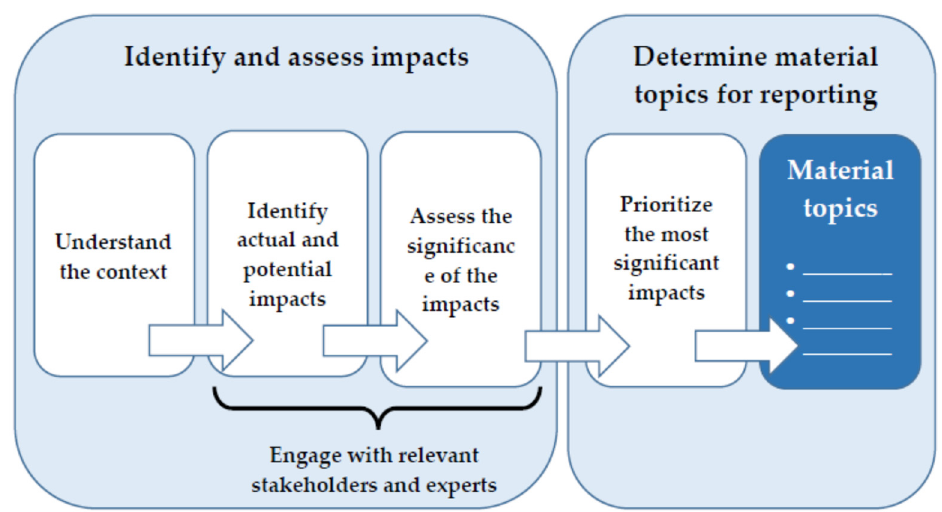
Figure 3. 2021 GRI 3 process to determine material topics: a schematization.